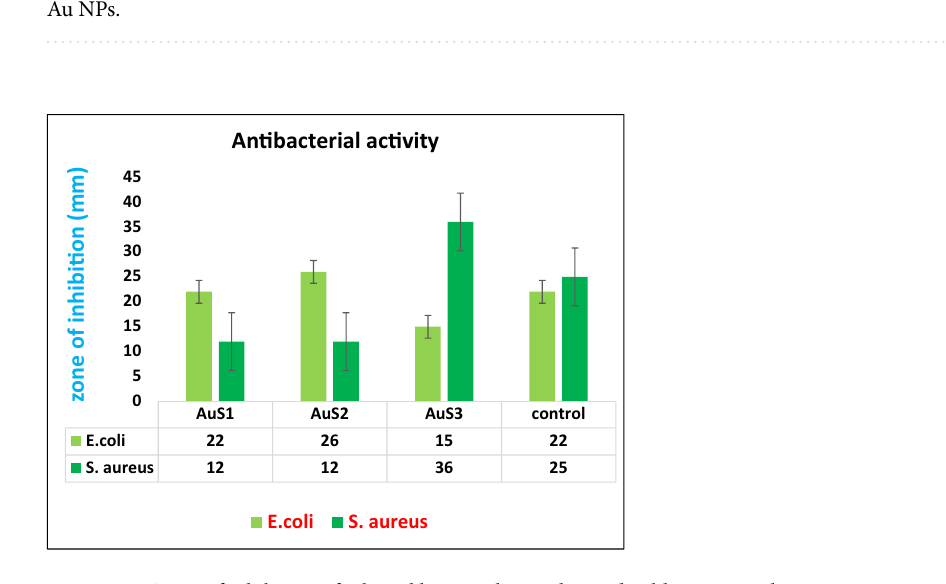
Figure 11. Zone of inhibition of selected bacteria by synthesized gold